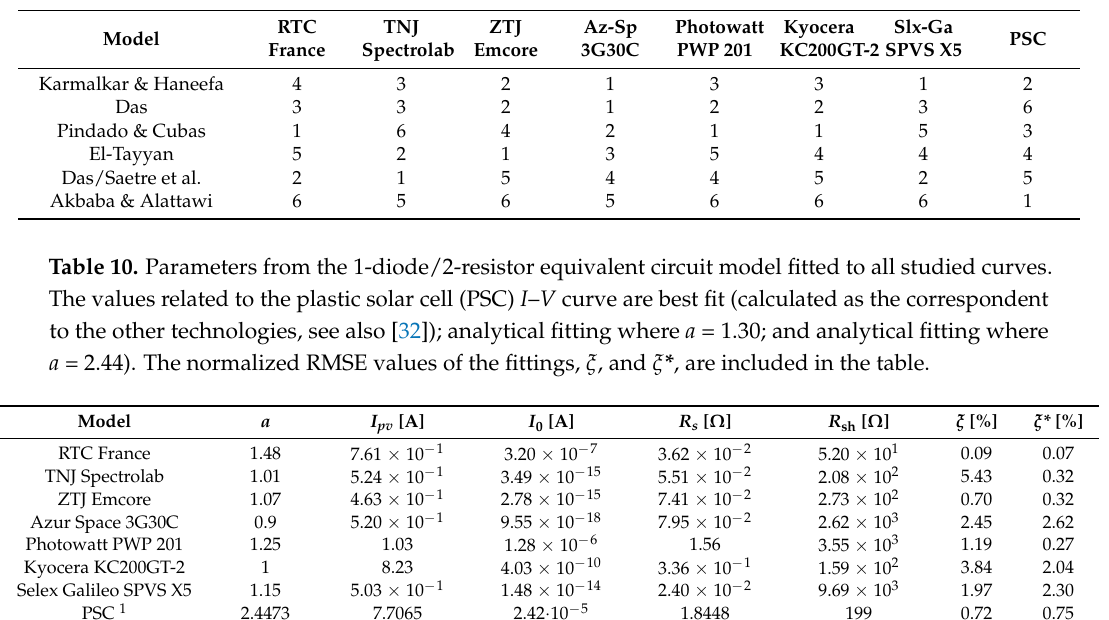
Table 9. Ranking of the explicit models studied, based on accuracy results (see Figure 15), by photovoltaic technology (see Tables 1 and 2).